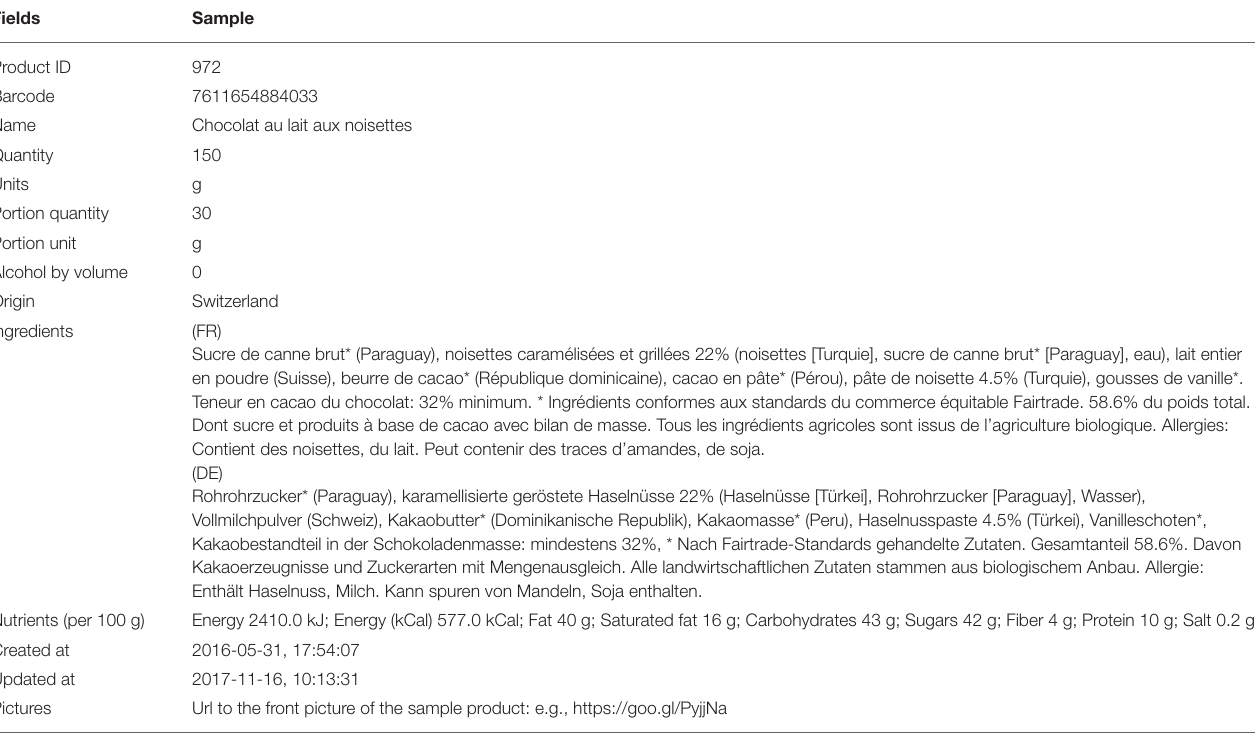
TABLE 1 | Sample product from the FoodRepo database with its values for the most relevant fields.